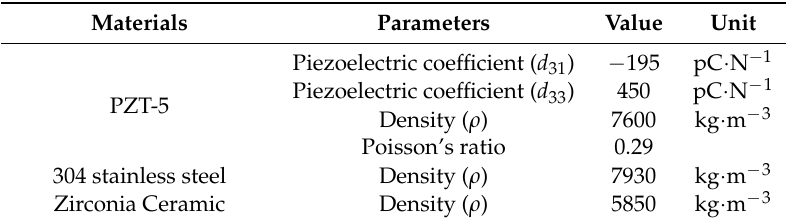
Table 1. Material parameters of the motor.